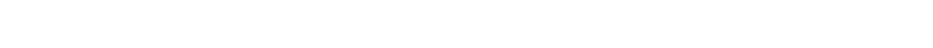
FIGURE 1 | Illustration showing known components of the oxygen-dependent erythrocyteATP release